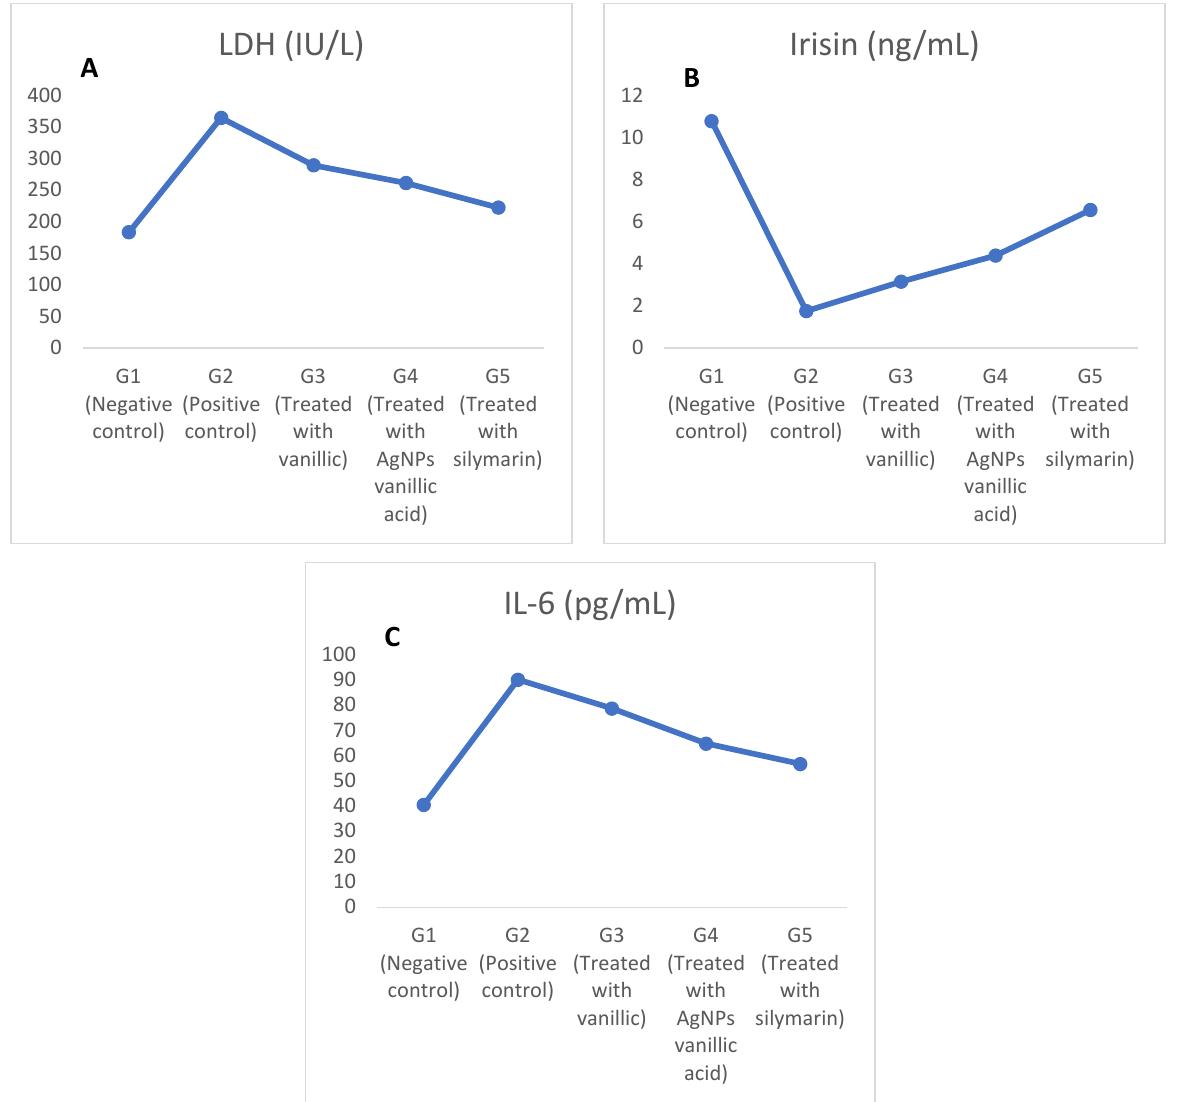
Figure 5. The effects of vanillic acid-loaded silver nanoparticles on serum lactate dehydrogenase (LDH), irisin, and IL-6 in CCl 4 liver toxicity-induced rats. ( A ): LDH, ( B ): Irisin, and ( C ): IL-6.